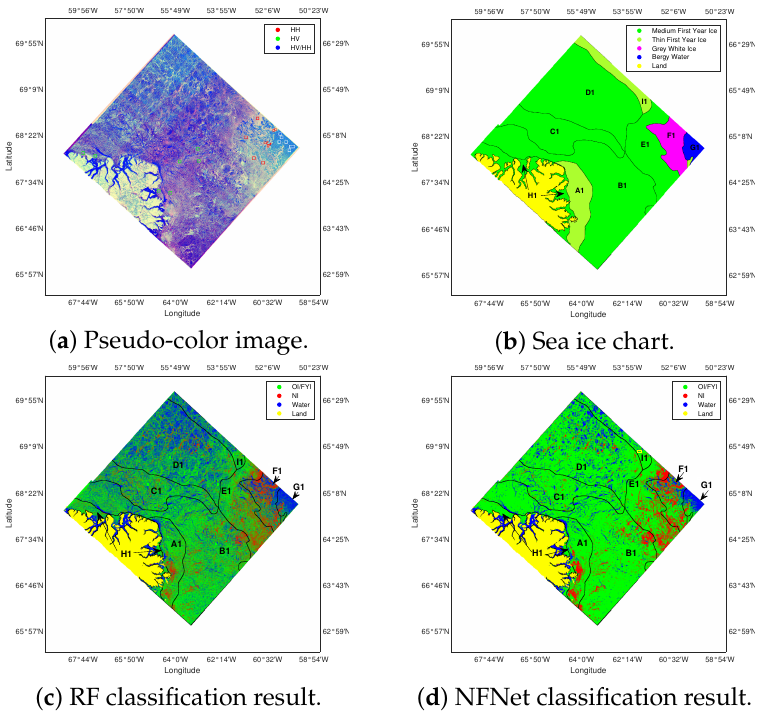
Figure 7. ( a ) Image acquired on 1 March 2021. The green rectangles display the locations of the training samples for OI/FYI. The red and white rectangles indicate the areas of the training and testing samples for NI and water, respectively. ( b ) Sea ice chart. ( c ) RF classification result. ( d ) NFNet classification